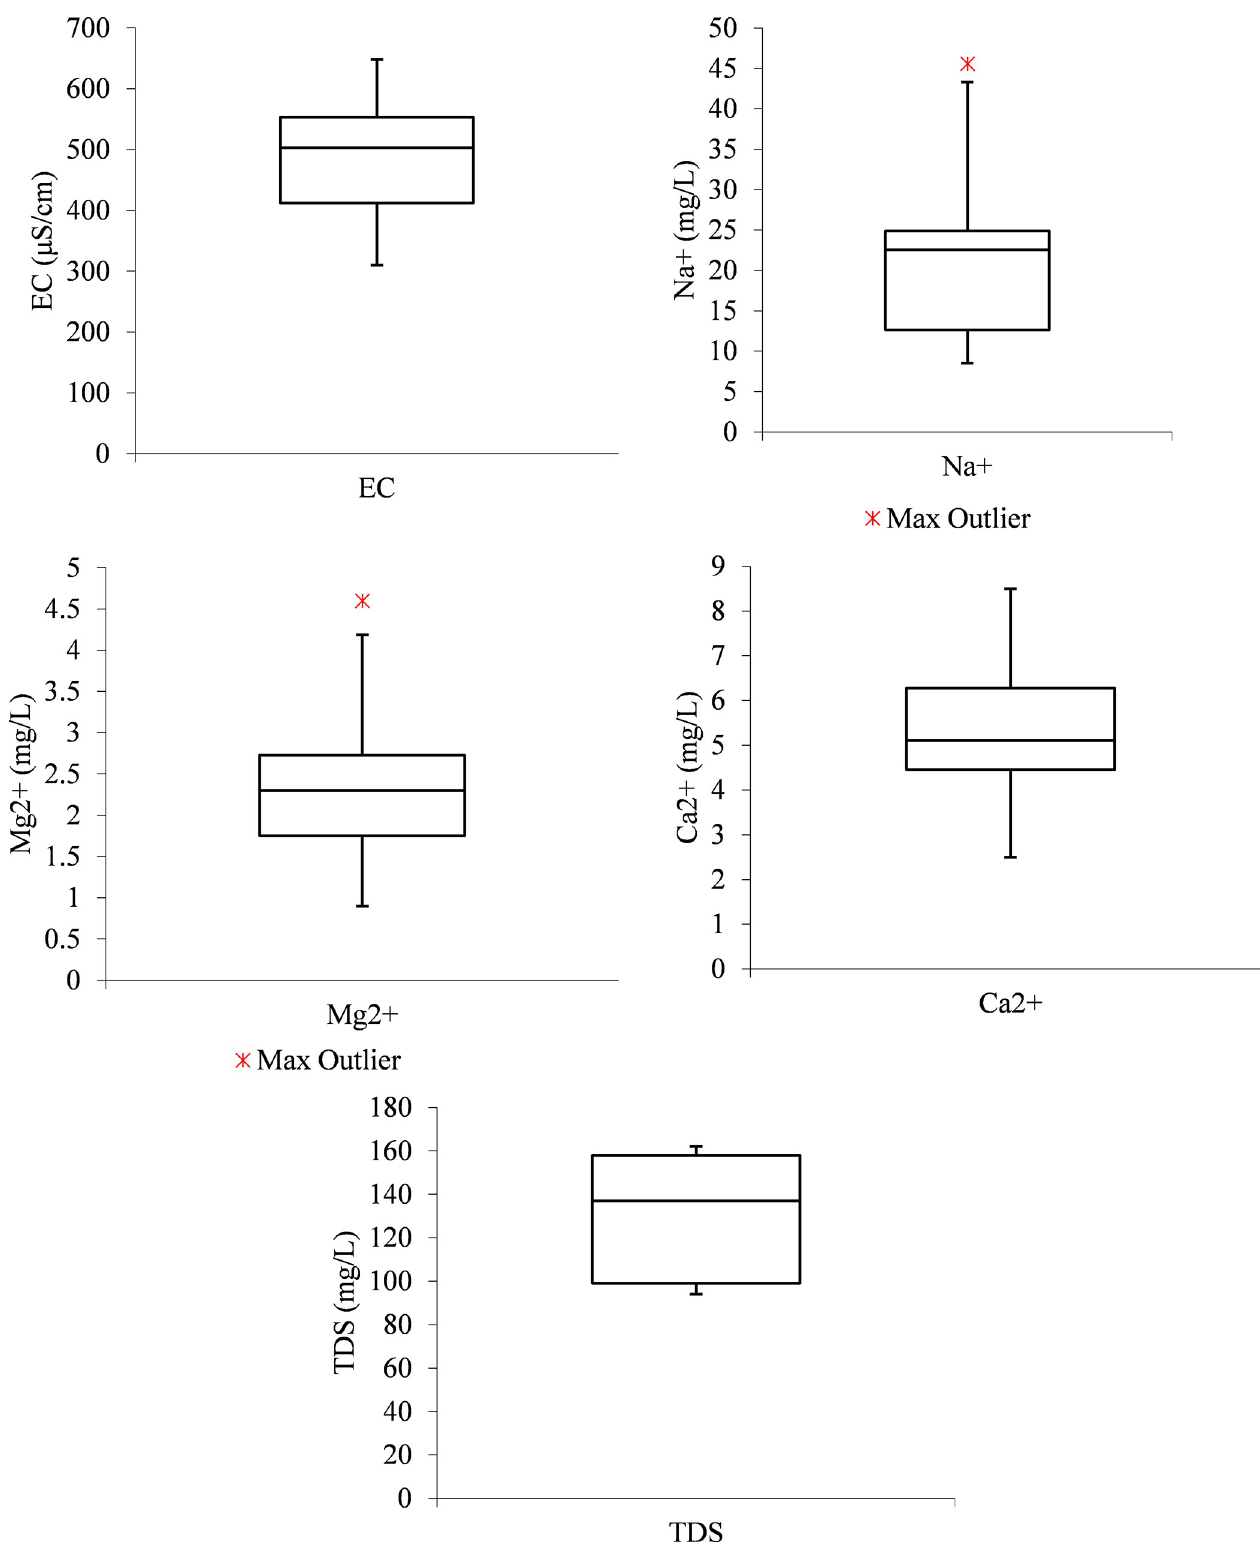
Fig 3. Boxplots from 1 m column effluent (a) EC (b) Na + (c) Mg 2+ (d) Ca 2+ (e) TDS.